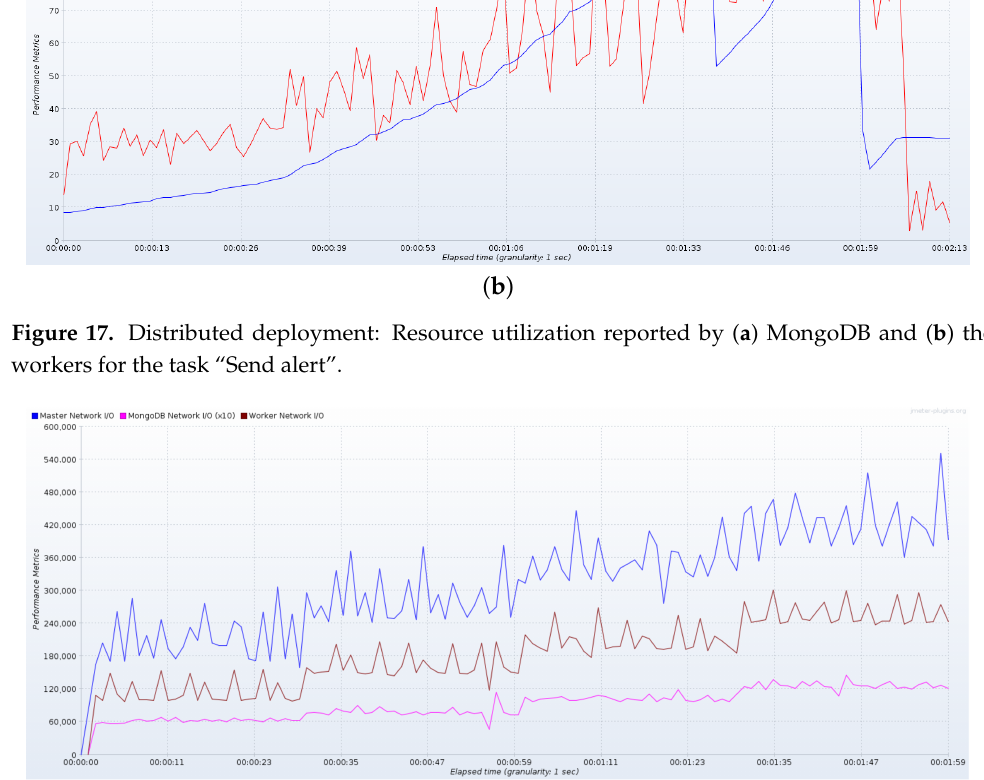
Figure 18. Communication cost in bytes reported by the Jayma